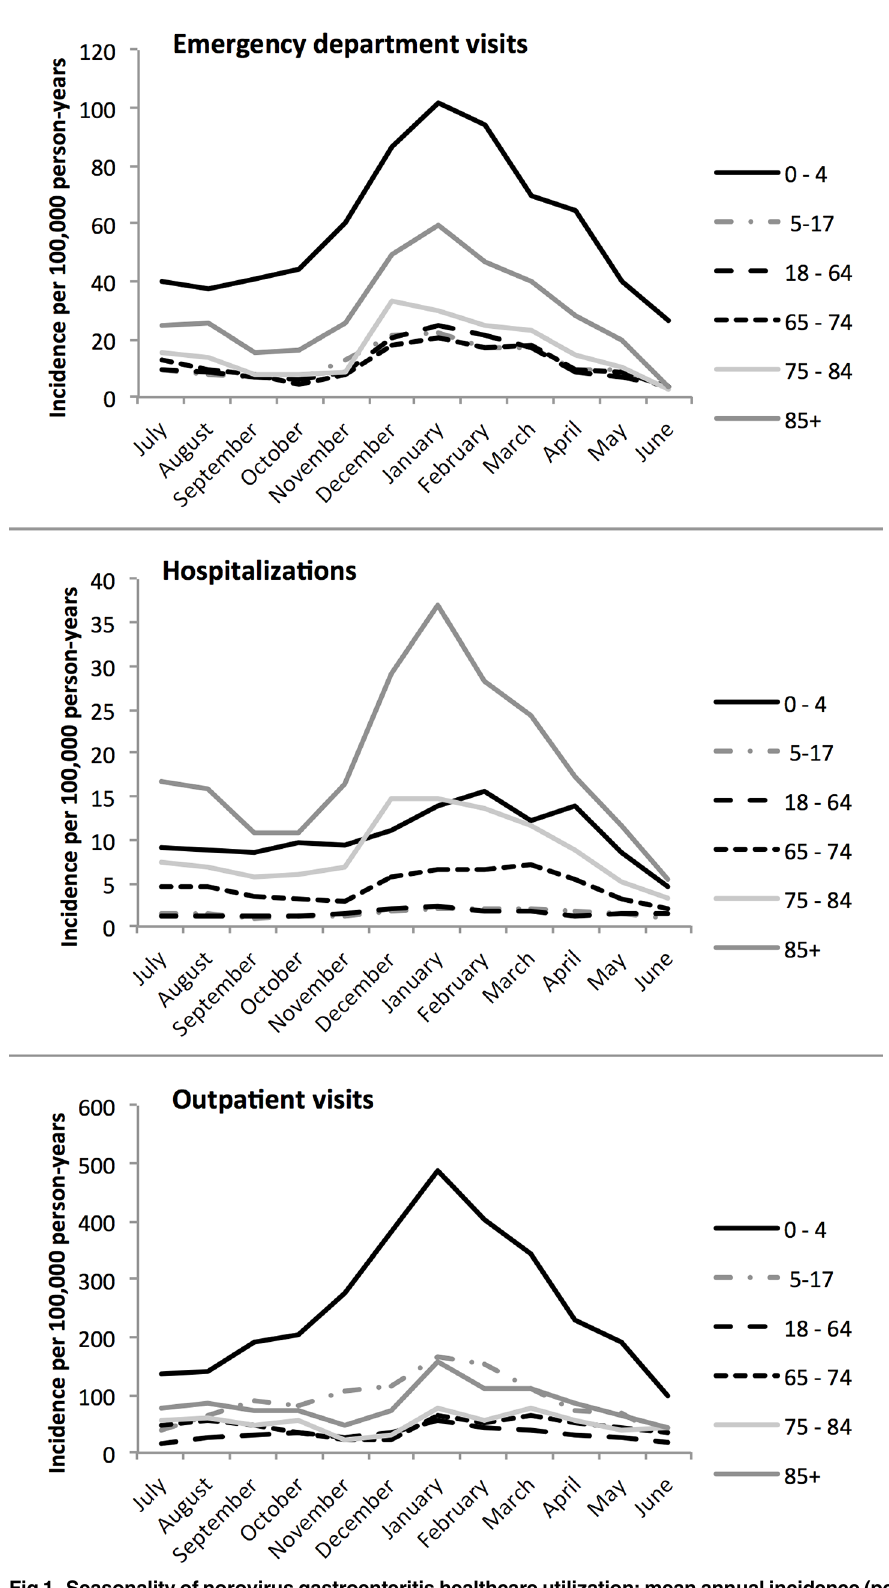
Fig 1. Seasonality of norovirus gastroenteritis healthcare utilization: mean annual incidence (per 100,000 population) by age (2002 – 2013). doi:10.1371/journal.pone.0158822.g001 PLOS ONE | DOI:10.1371/journal.pone.0158822 July 20,